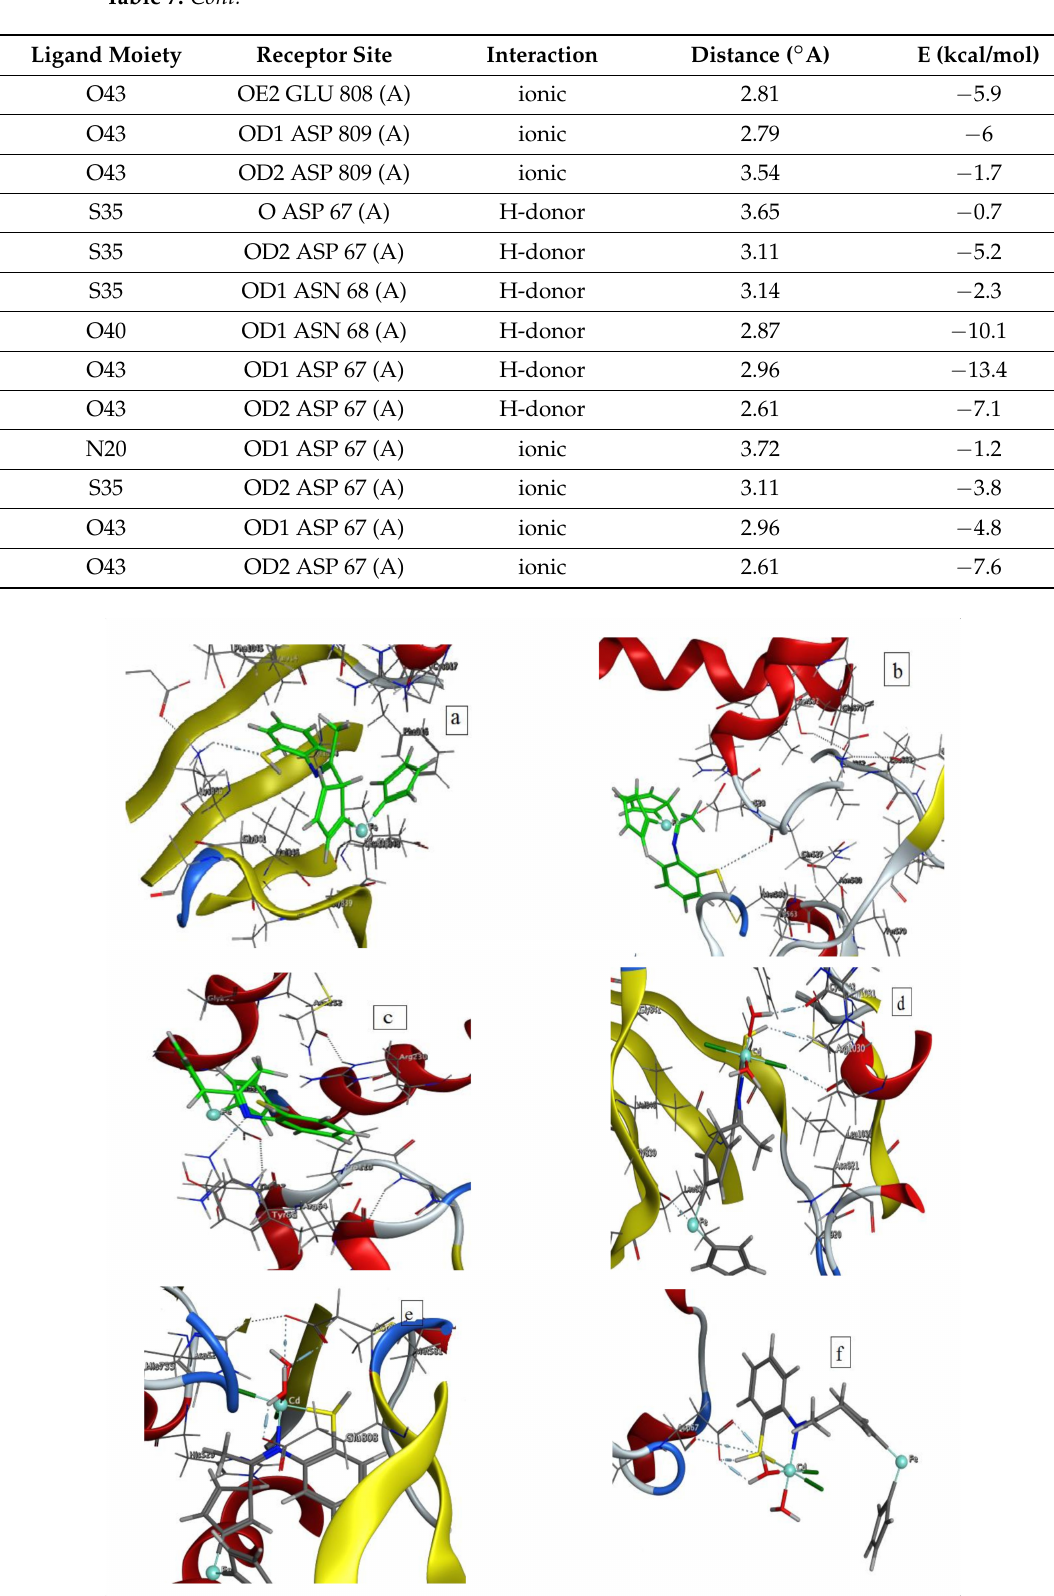
Figure 7. 3D plot of the interaction between the free ligand with receptors of ( a ) 1Y6a, ( b ) 2rgr and ( c ) 3 T88 and 3D plot of the interaction between Cd(II) chelate with receptors of ( d ) 1Y6a, ( e ) 2rgr, and ( f ) 3